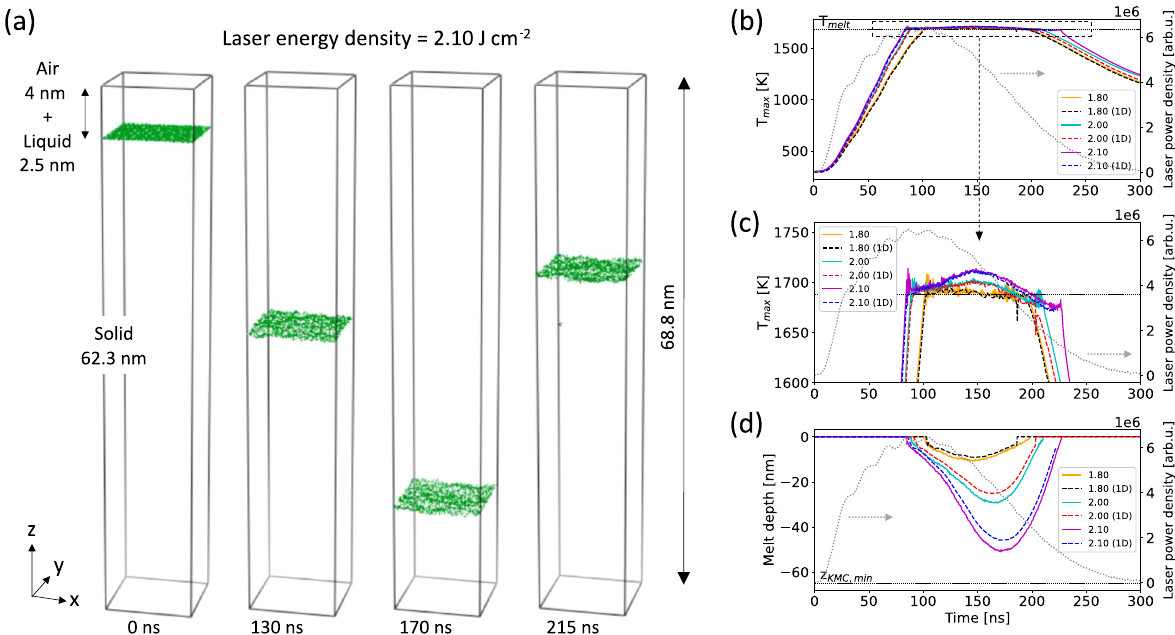
Fig. 4 FEM-KMC simulations of Si(100) laser annealing in the homogeneous nucleation case and comparison with 1D phase fi eld. a KMC box containing all undercoordinated solid atoms (green), identifying the solid – liquid Si interface at t = 0, 130, 170, and 215 ns upon irradiation with a laser energy density of 2.1 J cm − 2 (see also Supplementary Movie 1). b Maximum T value in the FEM mesh as a function of time (solid lines), for laser energy densities of 1.8, 2.0, and 2.1 J cm − 2 , in comparison with the results of 1D phase- fi eld model (dashed lines) using the same geometry and optical parameters. The power density of the laser pulse over time is also shown as black dotted line. c Zoom of the curves in ( b ) around T M . d Variation of melt-depth over time for the same fl uences (solid lines), in comparison with the results of the 1D phase- fi eld model (dashed). The former are extracted as average z coordinate of solid Si atoms at the interface at the end of every KMC step. The maximum accessible depth for melting z KMC in the KMC model is also indicated.